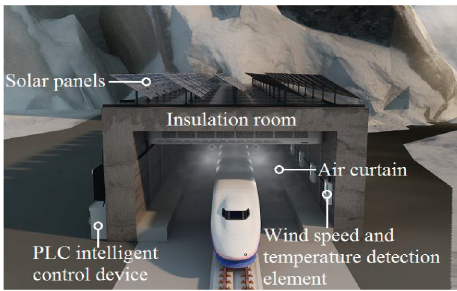
Figure 1: Structure of the tunnel air curtain insulation system on the sunny side of the mountain.